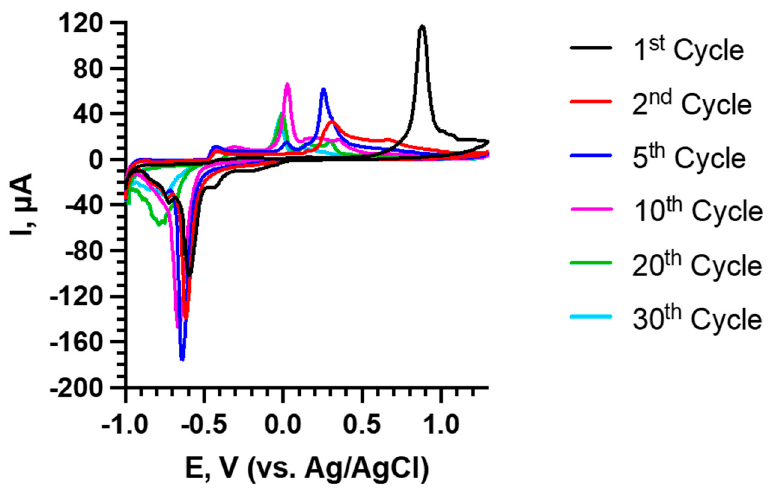
Figure 4. Bi 2 Se 3 thin films CVs in − 1.0 ÷ 1.3 V vs. Ag/AgCl potential range at scan rate 1.0 mVs − 1 , 30 cycles.